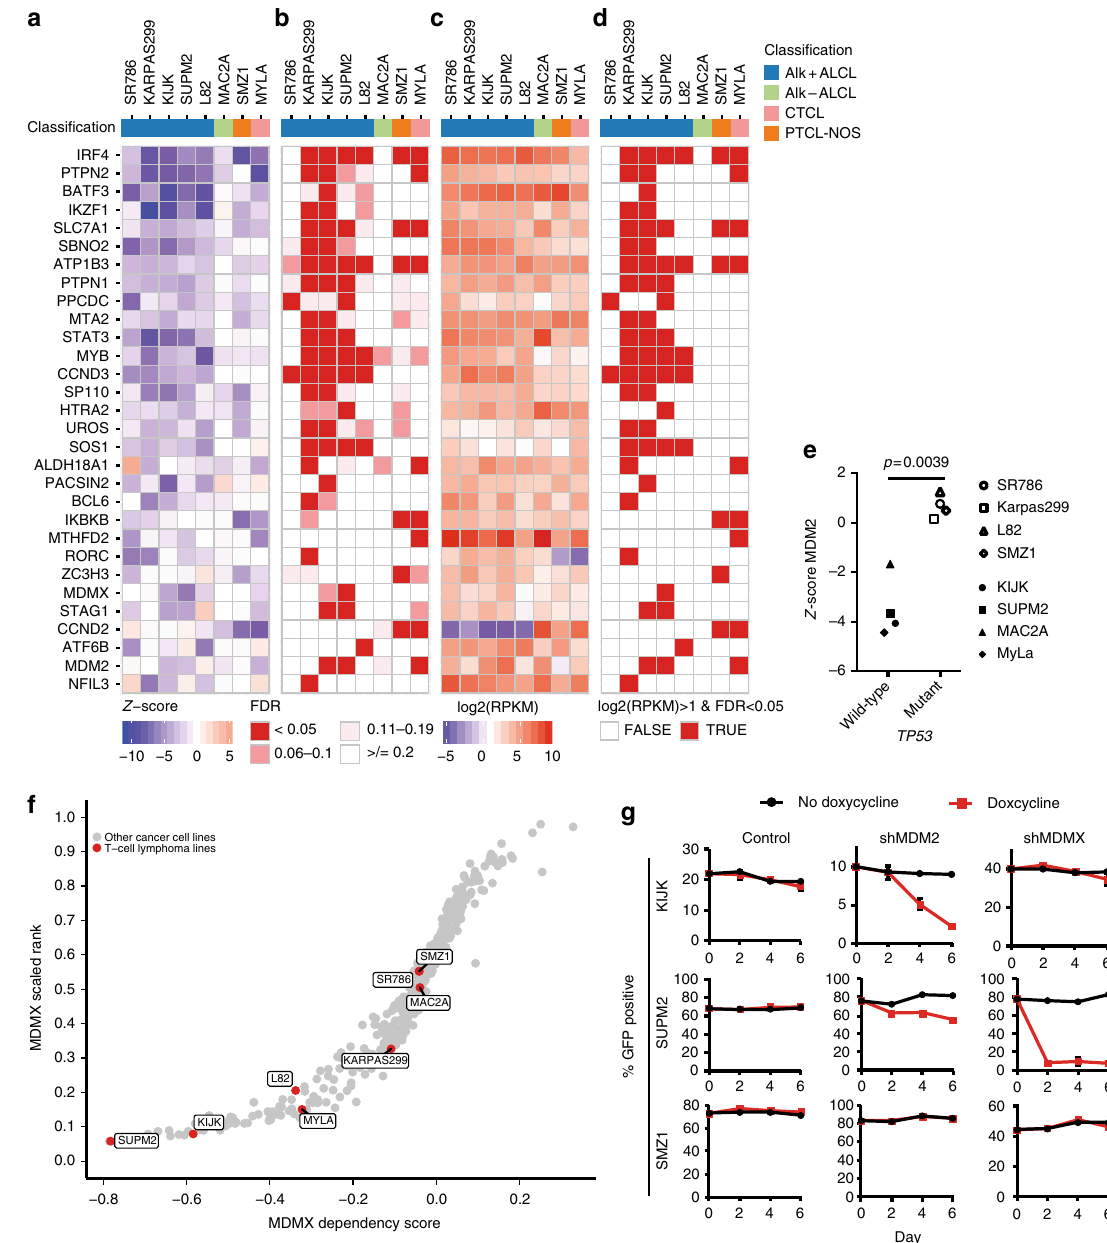
Fig. 2 Genome-scale vulnerability screens reveal unique and common targets. a T-cell lymphoma speci fi c vulnerabilities, ranked by Z -score and recurrence. b Corresponding false-discovery rate (FDR) q -values. c Corresponding gene expression level; RPKM, reads per kilobase of transcript, per million mapped reads. d Combined gene expression level and FDR. e Dependency score of MDM2 in TP53 -wild-type versus TP53 -mutated cell lines. Comparison is by two-sided t -test with Welch correction. f MDMX dependency score across 391 cancer cell lines with TCL lines highlighted in red. g Knockdown of MDM2 and MDMX in TP53 -wild-type cell lines KI-JK and SUP-M2 and TP53 -mutated cell line SMZ-1 using GFP-expressing, doxycycline inducible shRNA. Data points indicate mean values with error bars indicating standard error of the